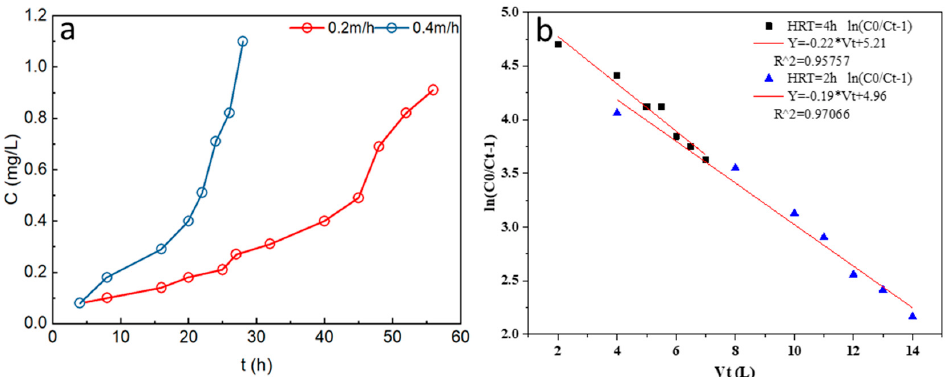
Figure 8. Column experiments with different HRT. ( a ) Shift of P concentration in effluent; ( b ) fitting curves of the Thomas model.